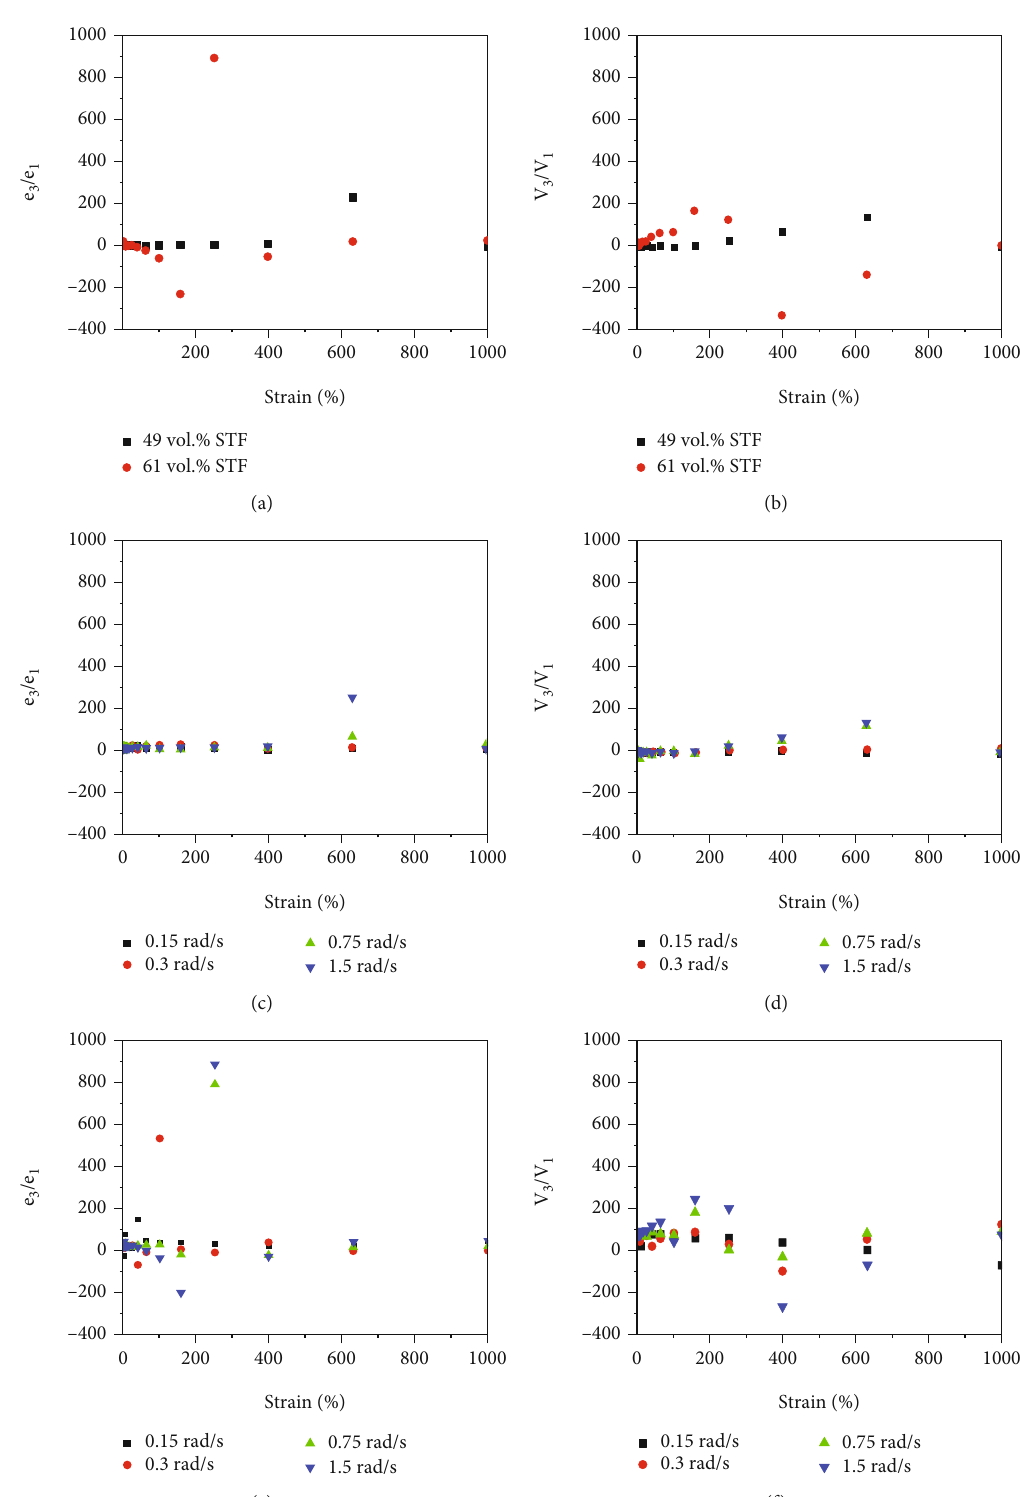
/ e v / v Figure 6: (a) The e 3 1 values and (b) the 3 1 values of 49vol.% STF and 61vol.% STF with the angular frequency at 1.5 rad/s. (c) The values and (d) the v 3 / v 1 values of 49vol.% STF in the angular frequency range from 0.15 to 1.5rad/s. (e) The e 3 / e 1 values and (f) the v 3 / v 1 values of 61vol.% STF in the angular frequency range from 0.15 to